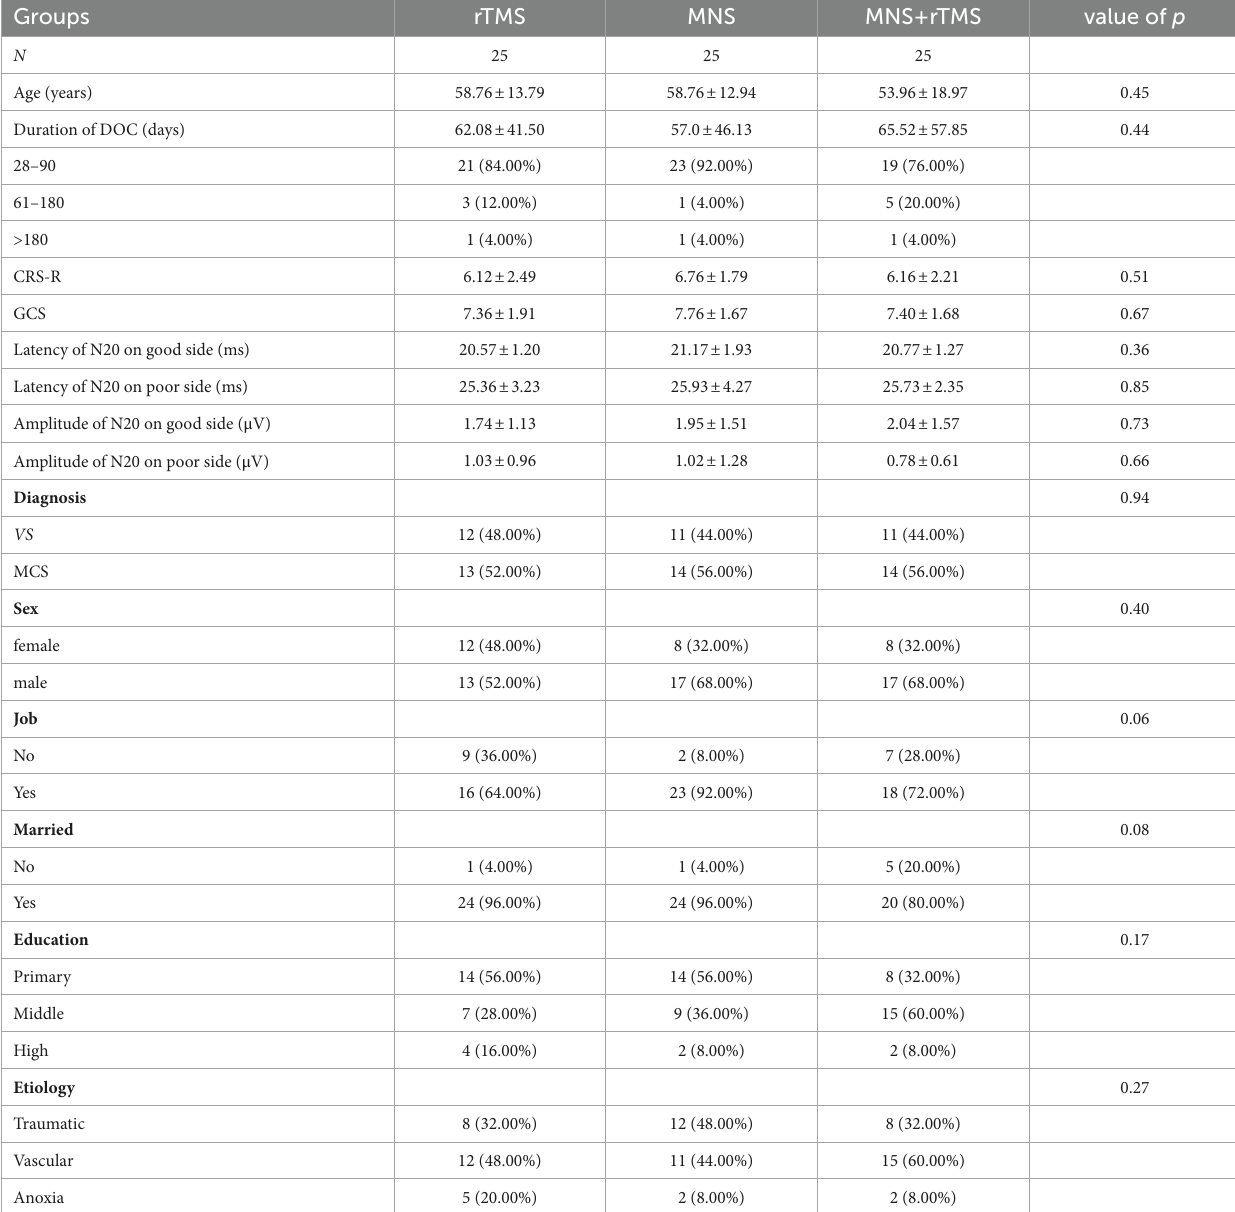
TABLE 1 Demographic and clinical characteristics of pDOC patients in the three groups.